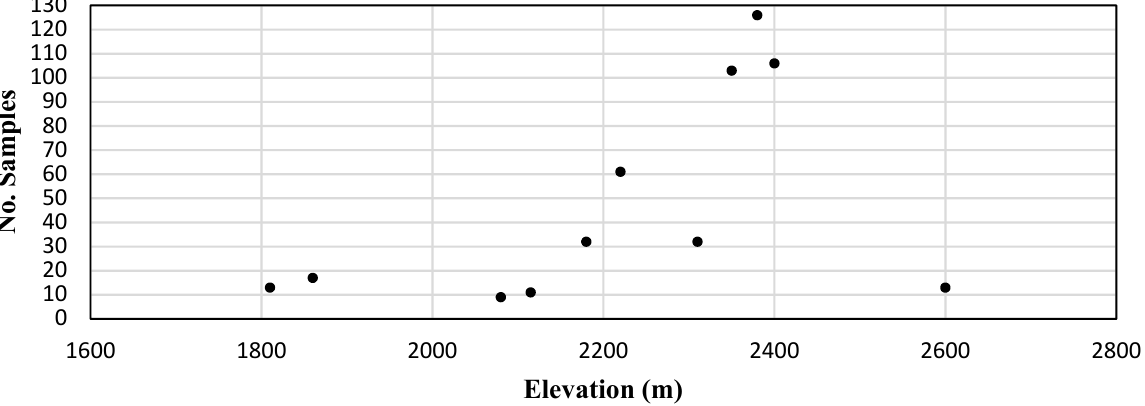
Figure 3. Number of snow density (SDEN) manual samples and elevation distribution.